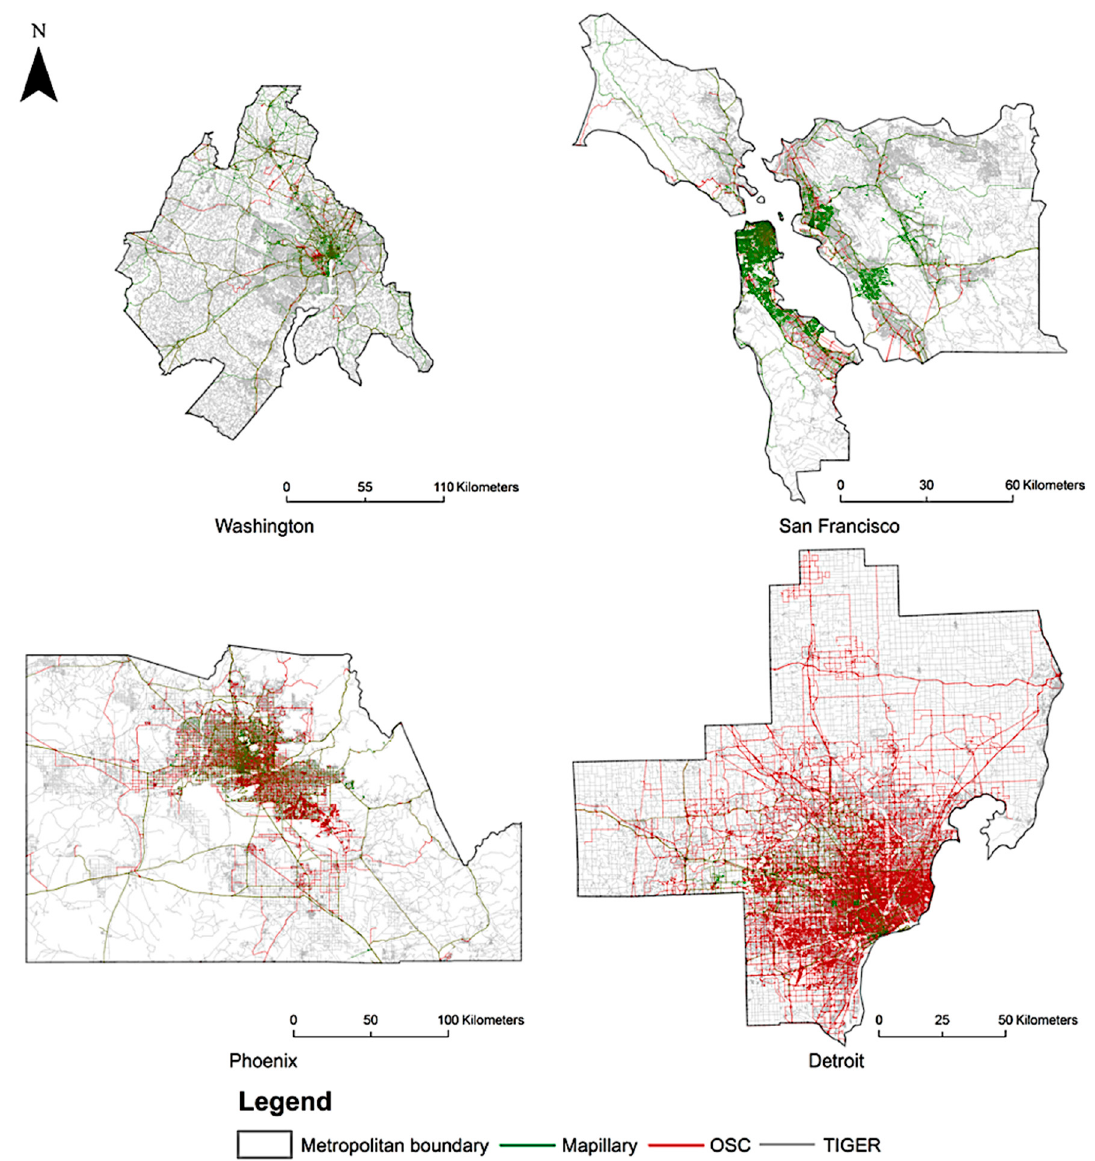
Figure 3. Spatial distribution of road networks.